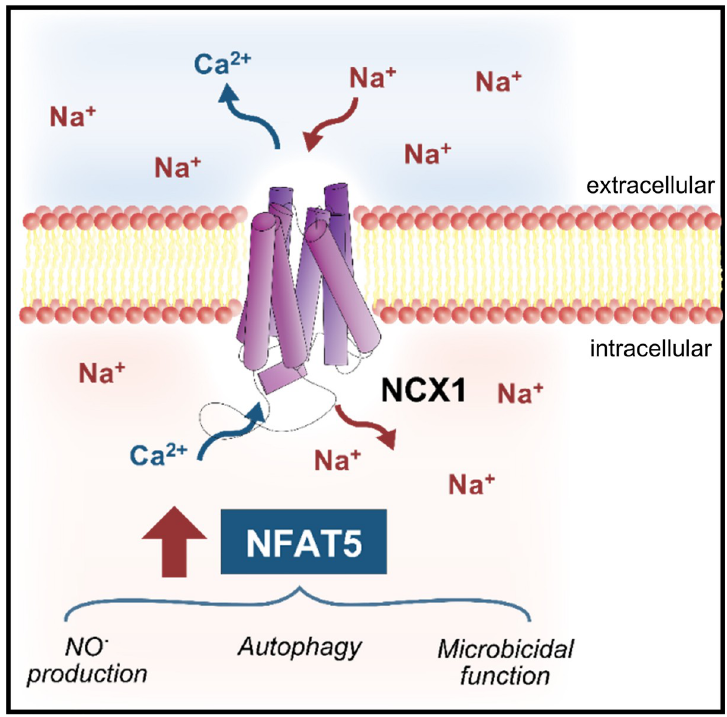
Fig 10. Graphical summary. NCX1 is required for Na + entry and Ca 2+ loss upon exposure of M F s to HS conditions. In LPS-stimulated M F s, NCX1 is required for HS-boosted NFAT5 accumulation and NO production. Moreover, NCX1 is required for enhanced autolysosome formation and bacterial removal upon HS exposure. HS, high salt; LPS, lipopolysaccharide; M F , monocyte/macrophage-like cell; NCX, Na + /Ca 2+ exchanger; NFAT5, nuclear factor of activated T cells 5; NO, nitric